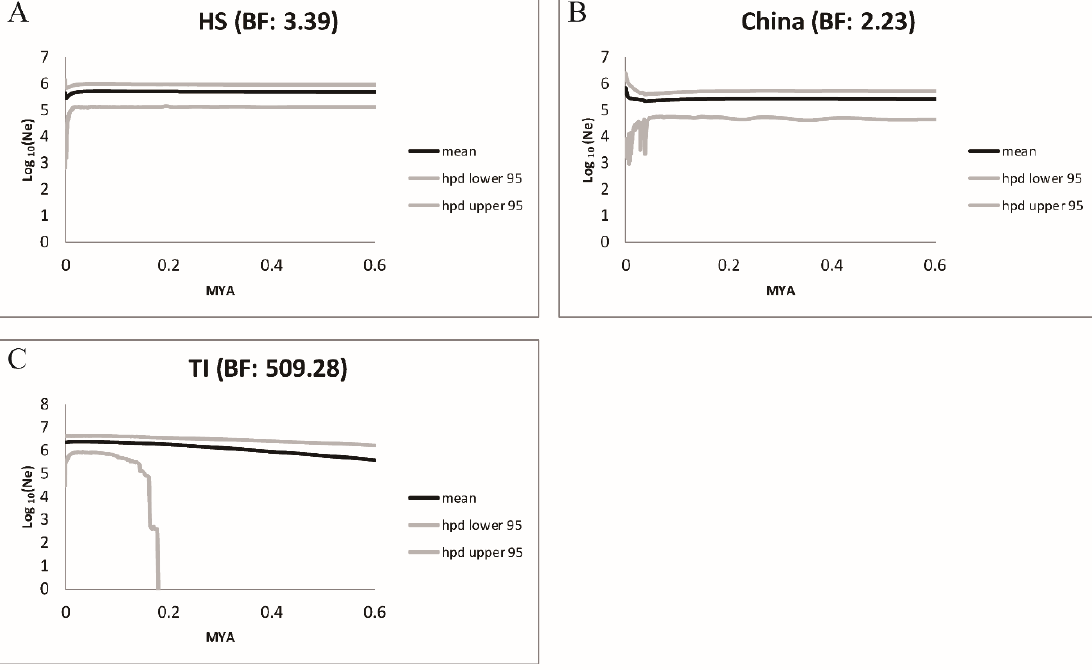
Figure 7. The effective population size changes over time of C. ramondioides groups. ( A ). HS: Hon- shu – Shikoku group, ( B ). China: Southeast China group, ( C ). TI: Taiwan – Iriomote group. Honshu–Shikoku group, ( B ). China: Southeast China group, ( C ). TI: Taiwan–Iriomote